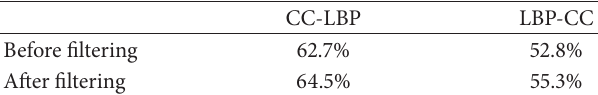
Table 4: Average precision rates before and after filtering in experiments (A) and (B).